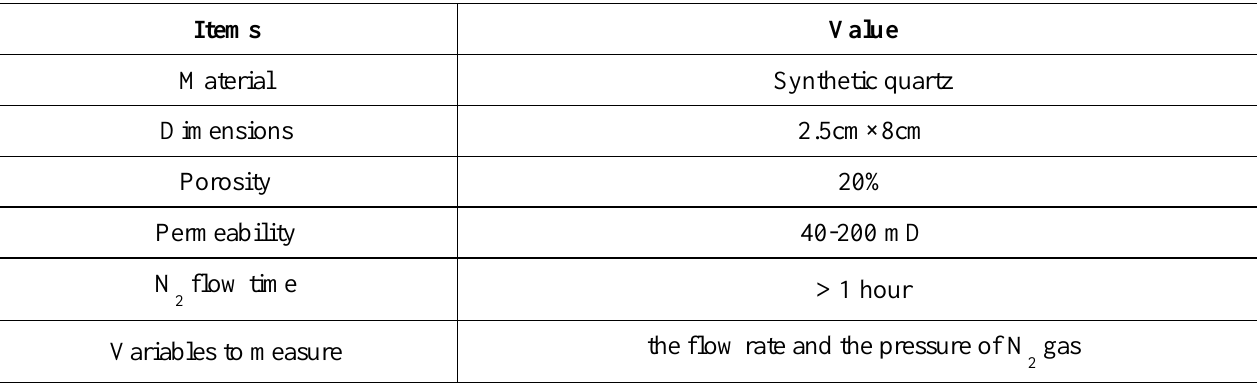
Table 6—Cores data for coreflood.